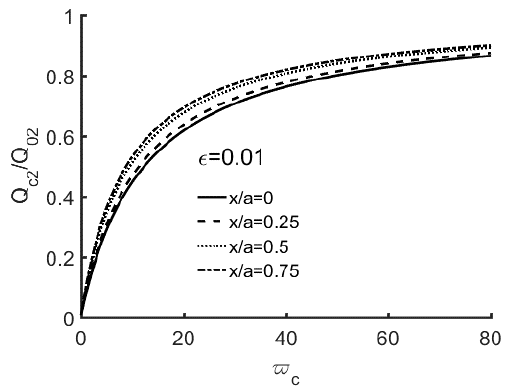
Figure 2. 𝑄 𝑐2 /𝑄 02 versus 𝜛 𝑐 with 𝜀 = 0.01 and 𝑥/𝑎 = 0, 0.25, 0.5, 0.75.